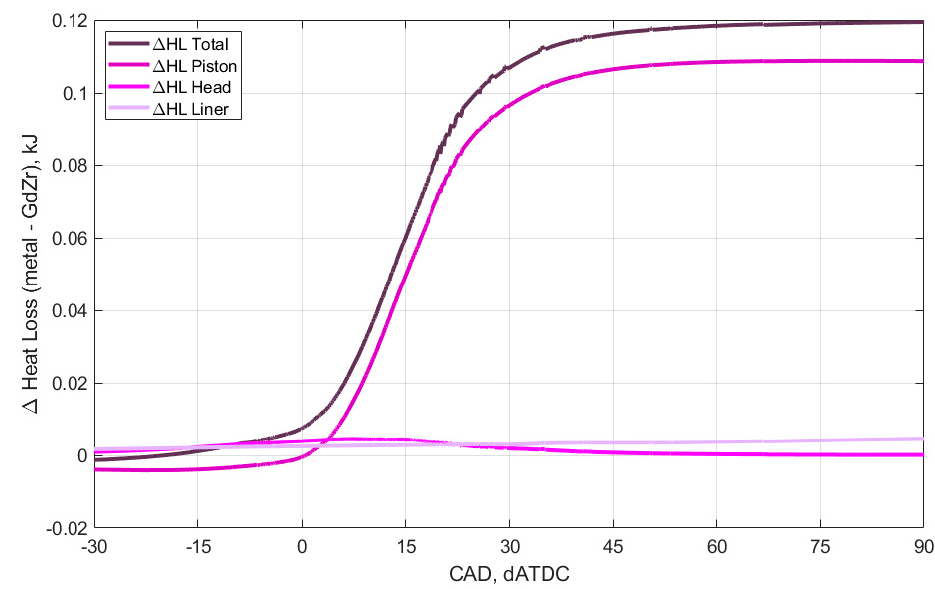
Figure 6. Instantaneous cumulative heat transfer losses; combined (piston + head + liner) and component-wise heat transfer losses.